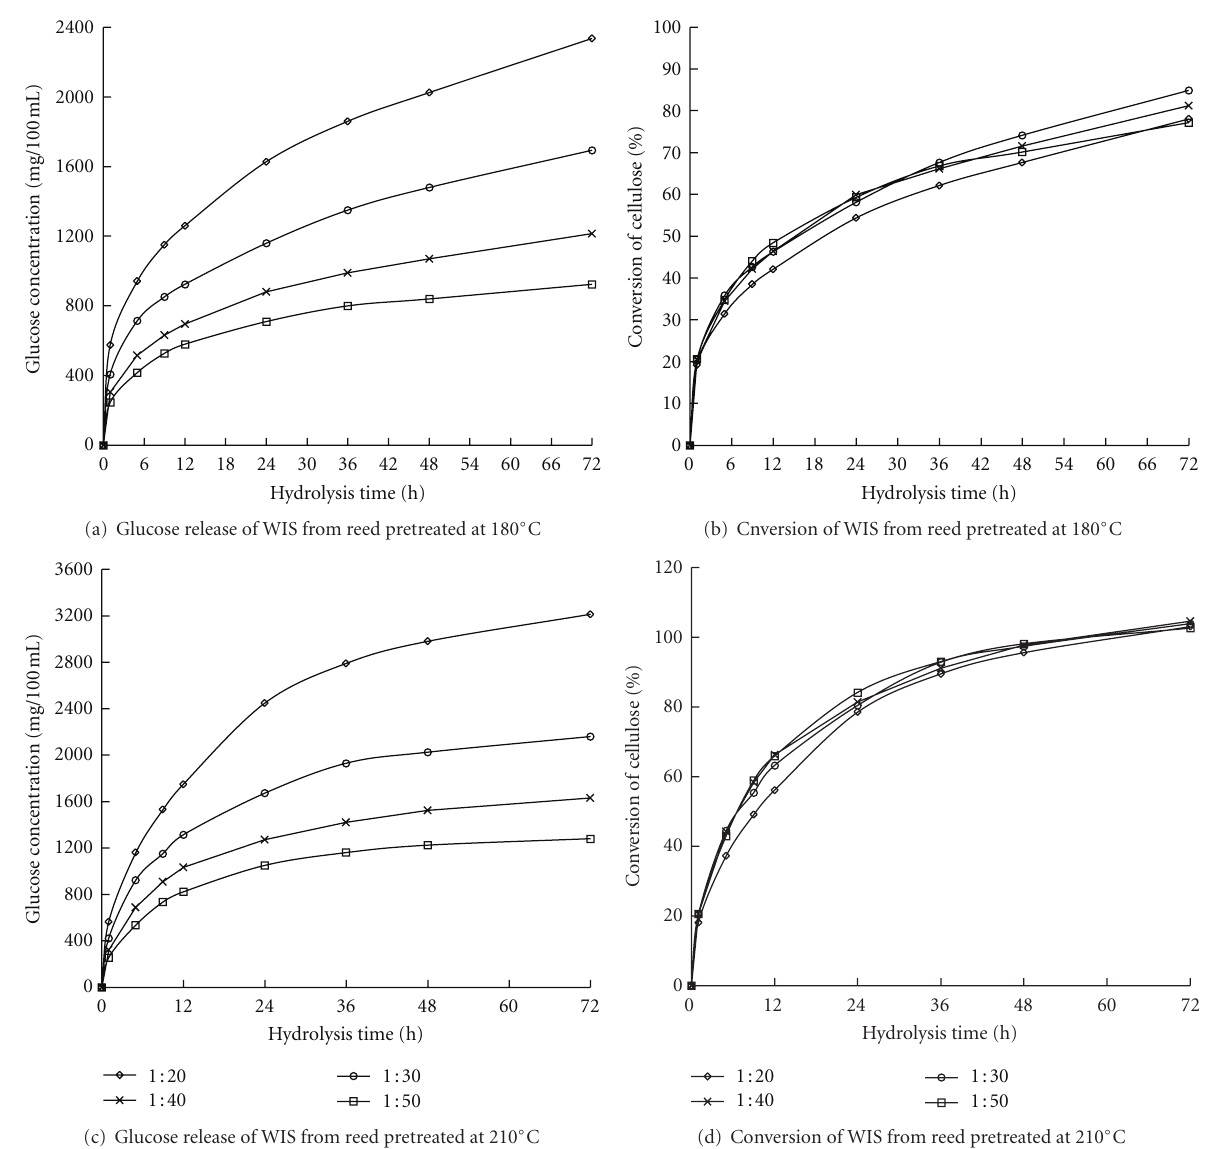
Figure 6: Enzymatic hydrolysis of WIS from reed pretreated at 180 ◦ C and 210 ◦ C with respect to di ff erent solid-to-liquid ratios in enzymatic